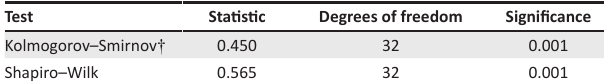
TABLE 7: Tests of normality.